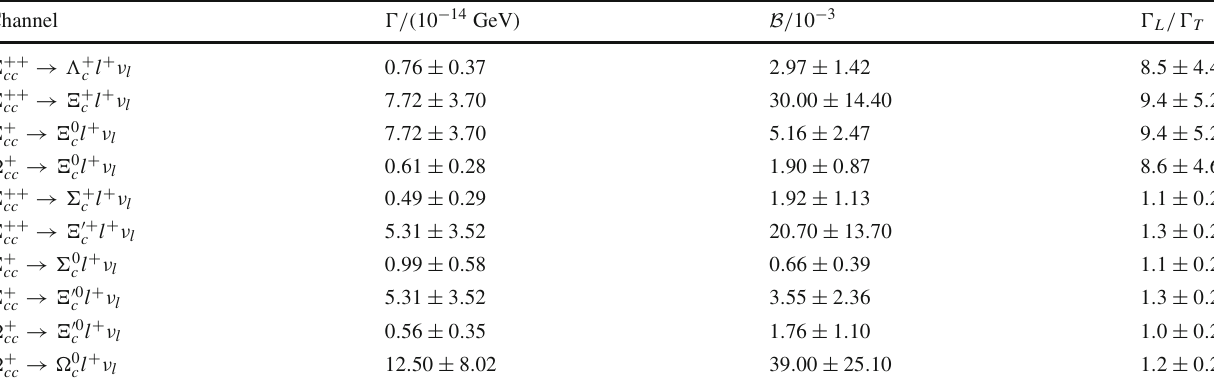
Table 15 Results for the semileptonic decays: the cc sector. The lifetimes of the initial baryons, which are used to derive the branching fractions, can be found in Table 4. Here l = e /μ . Here we have only considered the uncertainties from the heavy quark masses Channel